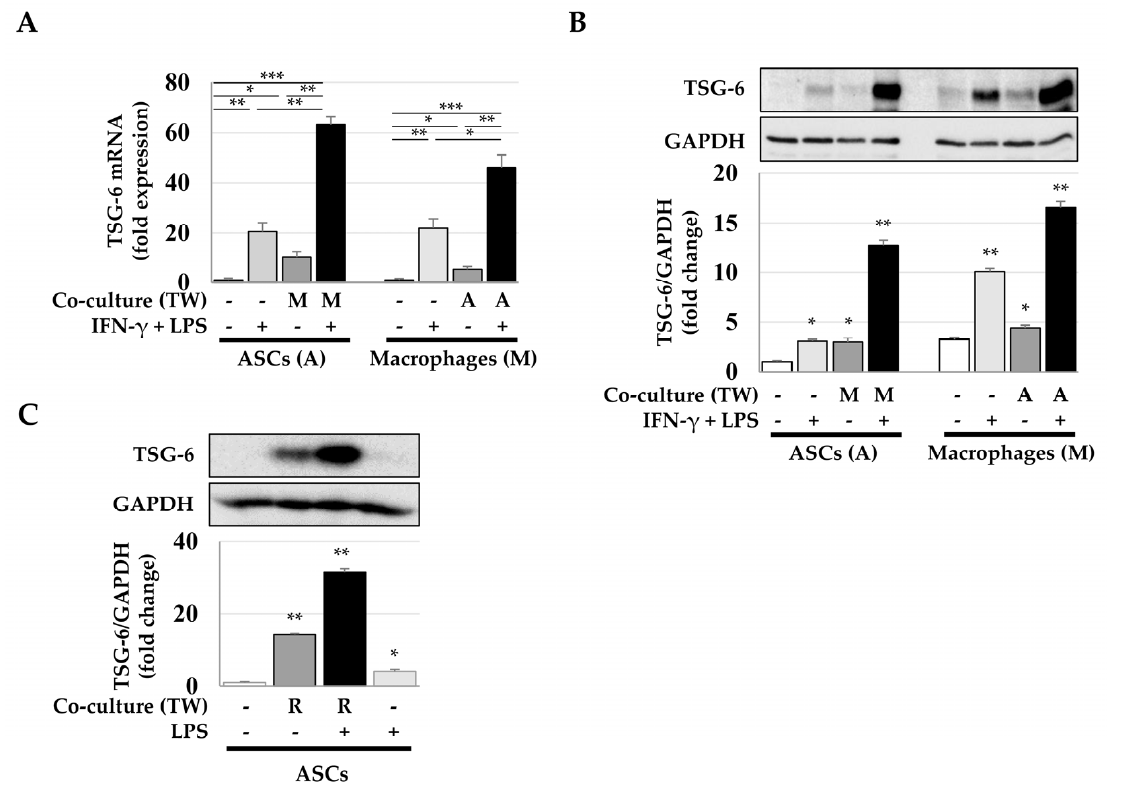
Figure 2. TSG-6 expression in ASCs and macrophages after indirect coculture. For indirect coculture using Transwell plates, ASCs and macrophages were seeded in upper and lower chamber (and vice versa) and then total RNA and protein samples were prepared from cells in the lower chamber. ( A ) Relative TSG-6 mRNA expression in ASCs and macrophages after indirect coculture. ( B ) Relative TSG-6 expression in ASCs and macrophages after indirect coculture. ( C ) TSG-6 expression in ASCs cocultured with RAW 264.7 murine macrophages. ASCs and RAW 264.7 cells were seeded in lower and upper chamber, respectively, and the TSG-6 expression in ASCs was analyzed using immunoblotting. Relative expression was normalized with respect to GAPDH expression. Data are presented as the mean ± SD of three independent experiments. * p ≤ 0.05, ** p ≤ 0.01, and *** p < 0.001. TW, Transwell; A, ASCs; M, macrophages; R, RAW 264.7 murine macrophages.